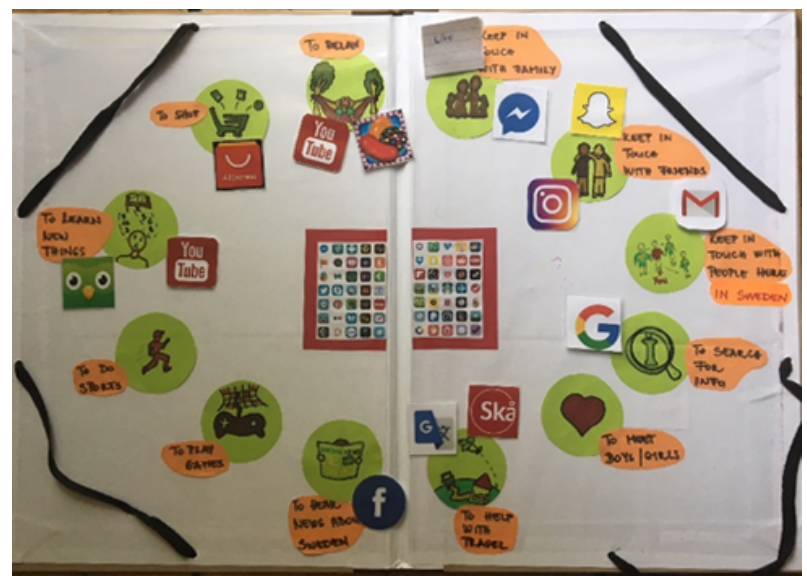
Figure 2. The “app board